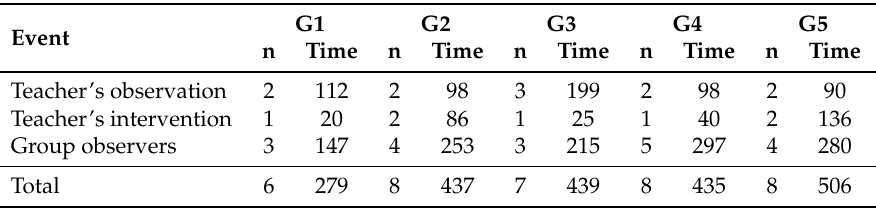
Table 2. Number and duration of events by